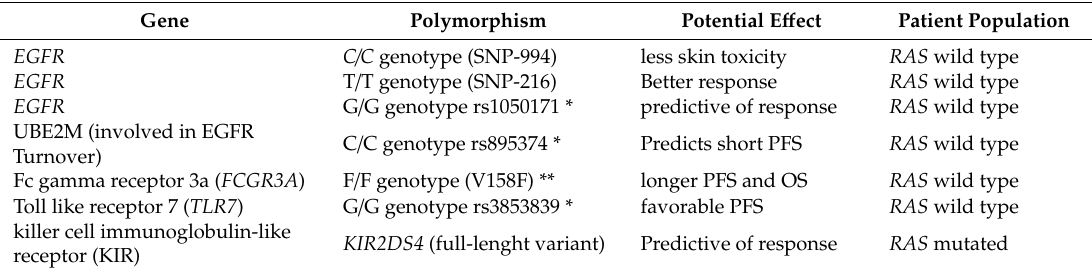
Table 2. Potential genetic polymorphisms predictive for anti-EGFR antibodies e ffi cacy in colorectal cancer reported in